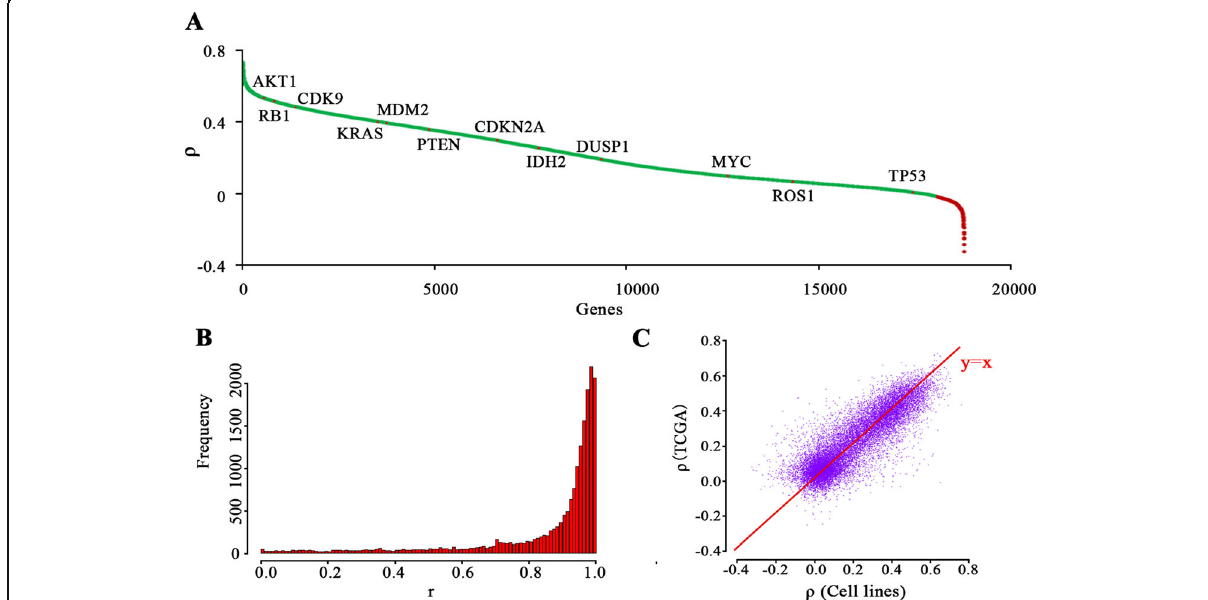
Fig. 2 Most genes ’ expression changes significantly correlated with their copy number variations. a. Genes were sorted according to ρ on Z score versus copy number across 9159 tumor samples from TCGA, green representing a positive ρ and red meaning a negative one, representative oncogenes and tumor suppressor genes next to the corresponding points. b. Histograms present the distribution of r for each genes based on the linear fitting results of median Z score with each variable copy number in TCGA datasets, the majority of Pearson ’ s r of fitting distributed ranging from 0.8 to 1. c. A high level of agreement on ρ for 16,639 shared genes between cell lines dataset and TCGA dataset, y-axis